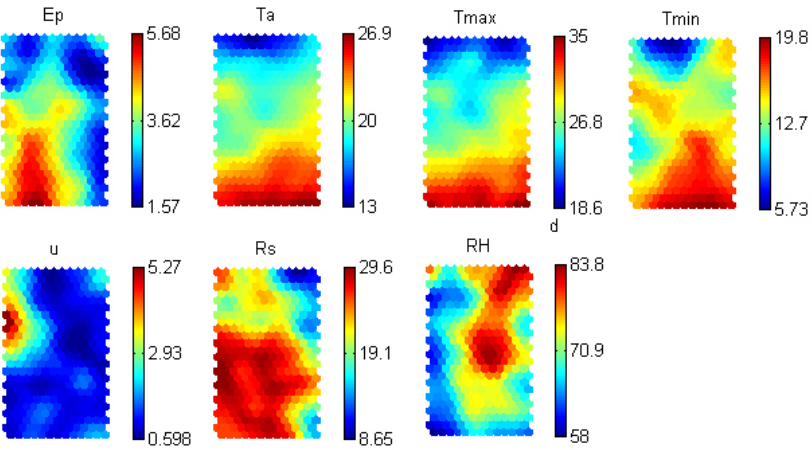
Figure 6. Kohonen self-organising map (K–SOM) visualisation of pan evaporation and meteorological variables assessment ( T a – daily mean temperature ( ◦ C), T max – daily maximum temperature ( ◦ C), T min – daily minimum temperature ( ◦ C), RH – relative humidity (%), R s – global radiation (MJm − 2 d − 1 ), u – wind speed (ms − 1 ), and E p – daily evaporation (mmd − 1 )). The bars indicate the intensity of the variables: the red colour is high importance and the blue colour is low importance.